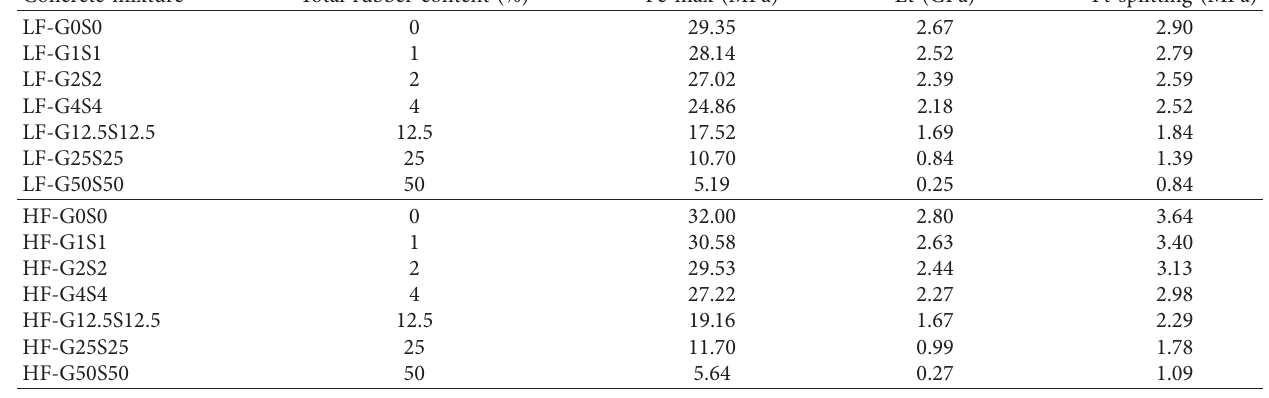
Table 5: Maximum stress and tangential moduli of elasticity and tensile splitting stress for HSRC at 28 days. Concrete